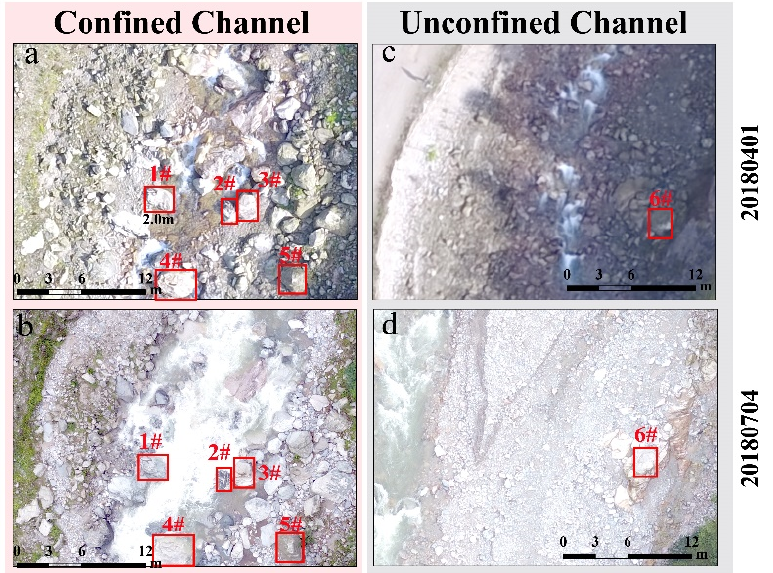
Figure 7. Distribution of grain in different channel part. ( a , b ) show the coarse layer generated in confined channel, box 1–6 shows the location of reference grains without moving under this flash flood; ( c , d ) show the unconfined channel with gravel and clay and little boulder. By contrast, the coarse layer did not generate in the unconfined channel, and the channel change response to a flash flood was more severe. The extension of the channel in the unconfined channel is significant after the earthquake. Under the same flow condi- tions, the shear stress of unconfined channels is less than that of confined channels because of the extended channel. In other words, the discharge of moving rocks of the same size needs to be larger. However, according to the law of material transportation in mountain- ous areas, the particle size in the lower reaches of the channel is smaller than that in the upper reaches by sorting (Figure 7c,d) [69–71]. Due to the less confinement of the uncon- fined channel, many debris flow materials were deposited here after the Wenchuan earth- quake. So, the transportation of material in this region is dominated by the transport-lim- ited process. It is more comfortable to cause drastic erosion and deposition or the chan- nel’s migration (Figure 6). 4.2. Effect of the Tributary and Channel width on the Channel Response Due to the complex distribution of the tributary and different channel widths in the Longxi River, different channel responses occurred, such as L1, L3, and L4. In order to analyze the effect of the channel width, the relationship between channel width and the volumetric change by this flash flood was obtained (Figure 8a). It was found that channel width controlled the change of channel. The larger channel width would have more space